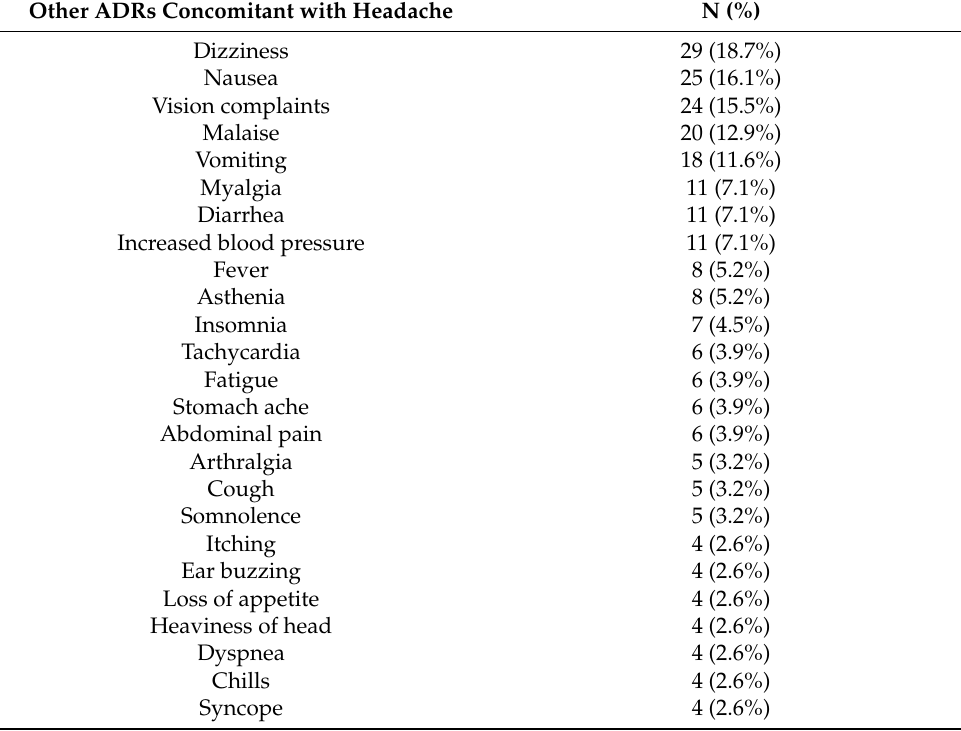
Table 3. Other adverse drug reactions (ADRs) concomitant with headache-ADR with relative fre- quency